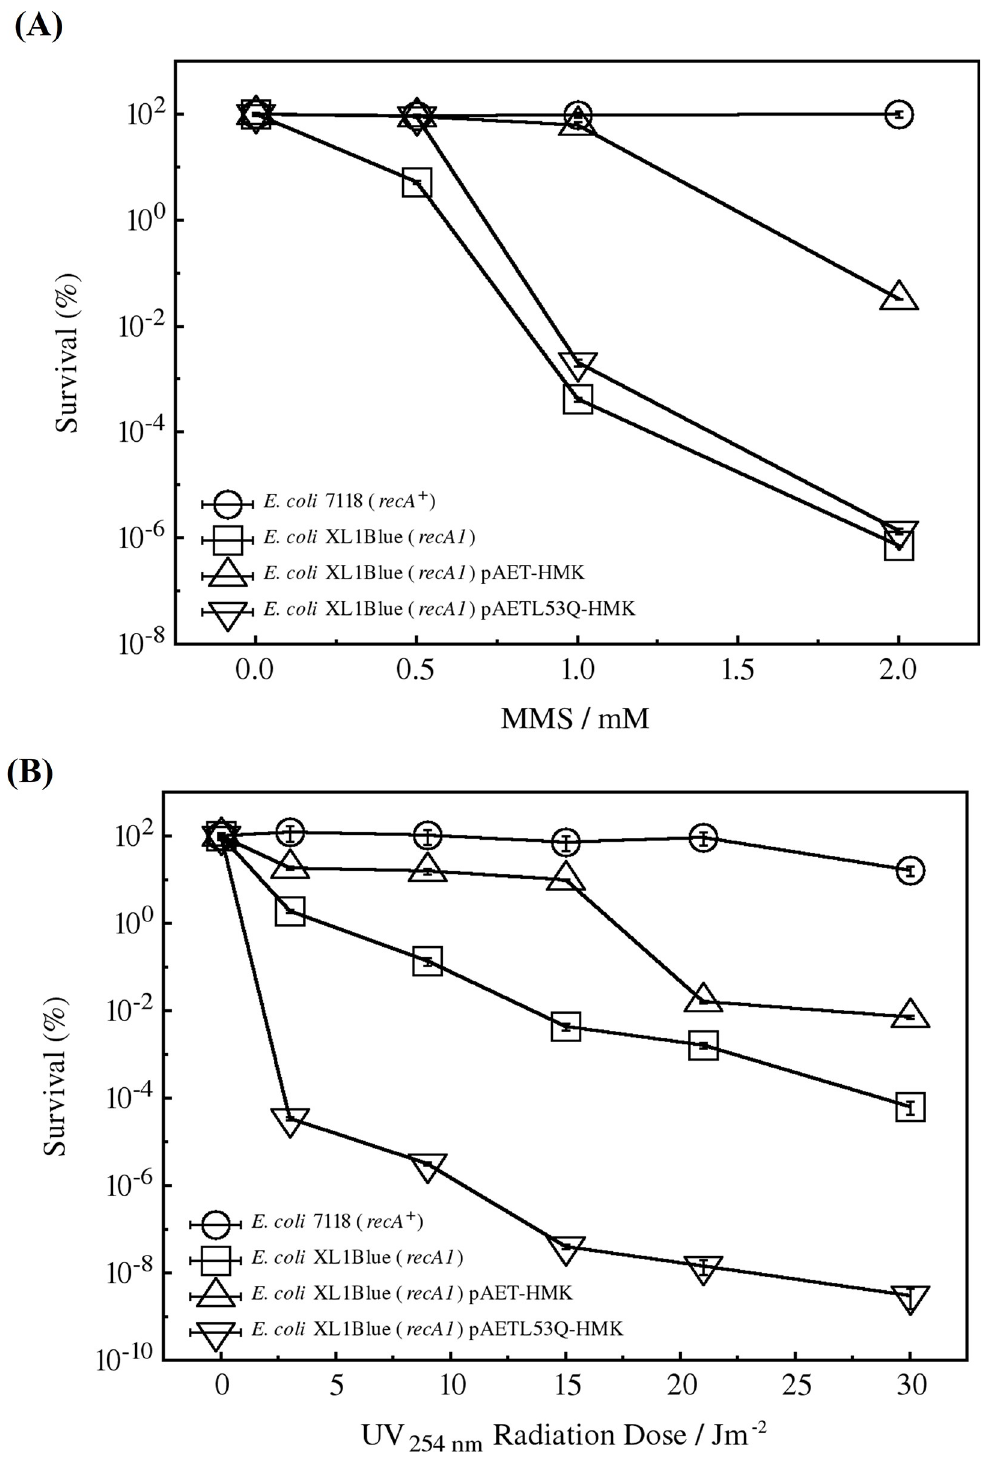
Fig 3. MMS and UV sensitivity of E . coli XL1Blue ( recA1 ) expressing the wild-type HsRecA or the mutant HsRecA L53Q. ( � ) E . coli 7118 ( recA +), ( □ ) E . coli XL1Blue ( recA1 ), and E . coli XL1Blue ( recA 1) harboring ( Δ ) pBMR503 (which encodes the wild-type HsRecA) or ( r ) pBMR503-L53Q (which encodes the mutant HsRecA L53Q) were challenged with increasing concentration of MMS (A) and doses (time of exposition) of UV radiation (B). Each data point represents mean + SD. The results are the average of two independent experiments in